Question: Identify the chart type used in this figure.
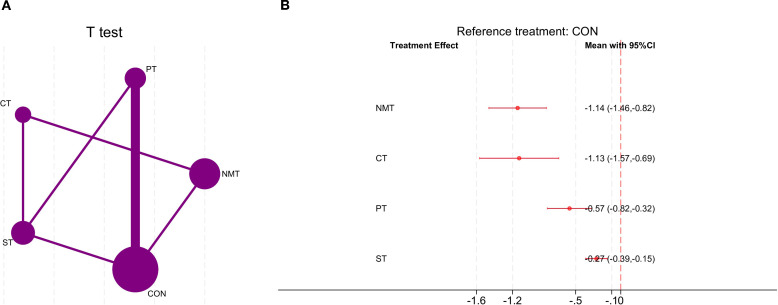
Answer: forest